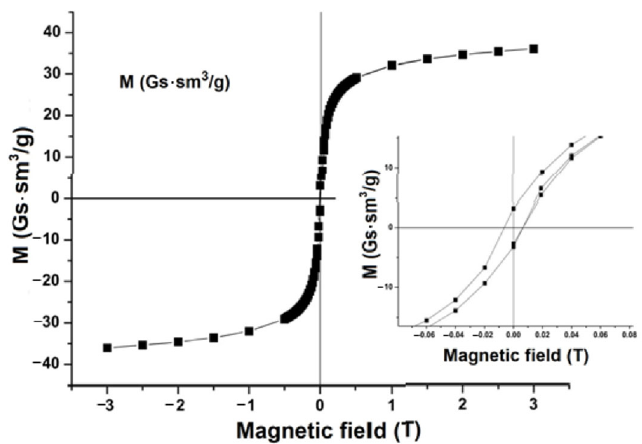
Figure 4. Magnetic hysteresis of magnetite nanoparticles at room temperature .